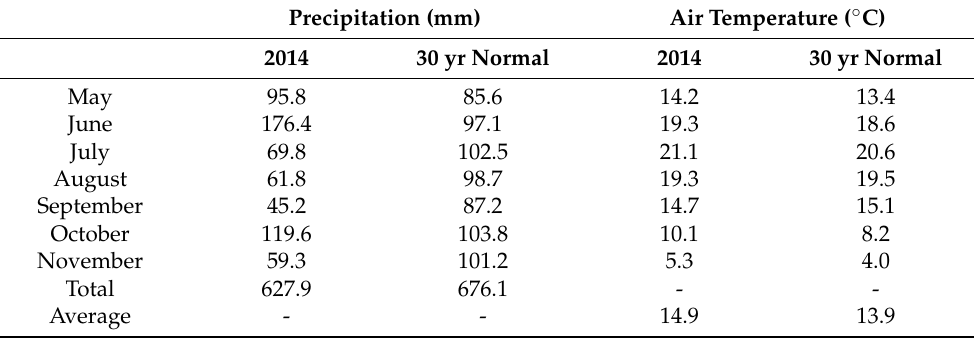
Table 1. Mean air temperature and precipitation during the growing season (May–November) in 2014 and 30 yr normal (1981–2010) based on the Ste Madeleine weather station (45 ◦ 37 (cid:48) N, 73 ◦ 08 (cid:48) W), Mont é r é gie